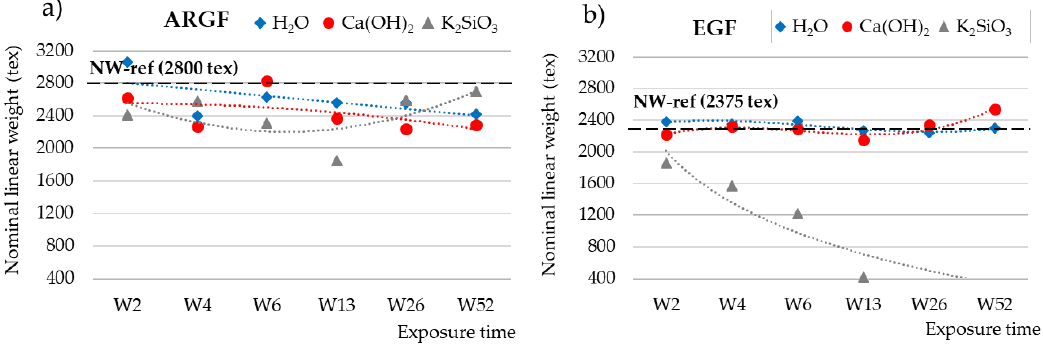
Figure 2. Nominal weights (tex) of ( a ) ARGFs and ( b ) EGFs treated in H 2 O, Ca(OH) 2 , and K 2 SiO 3 according to the exposure time. The points represent the measured values for the nominal weight, and the lines represent the trend lines. The nom- inal weights of the reference samples were ( a ) 2800 tex for the ARGFs and ( b ) 2375 tex for the